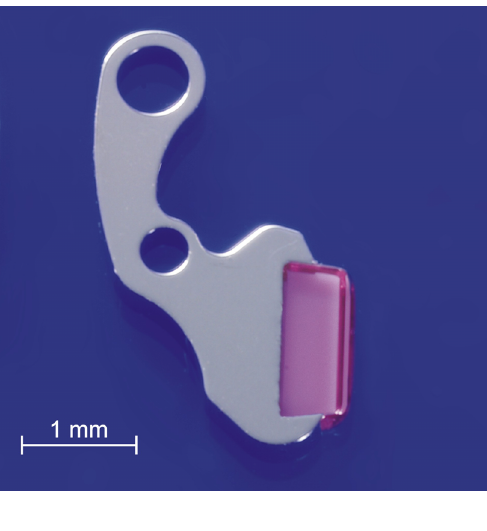
Figure 7. Carrier lever with integrated ruby to reduce